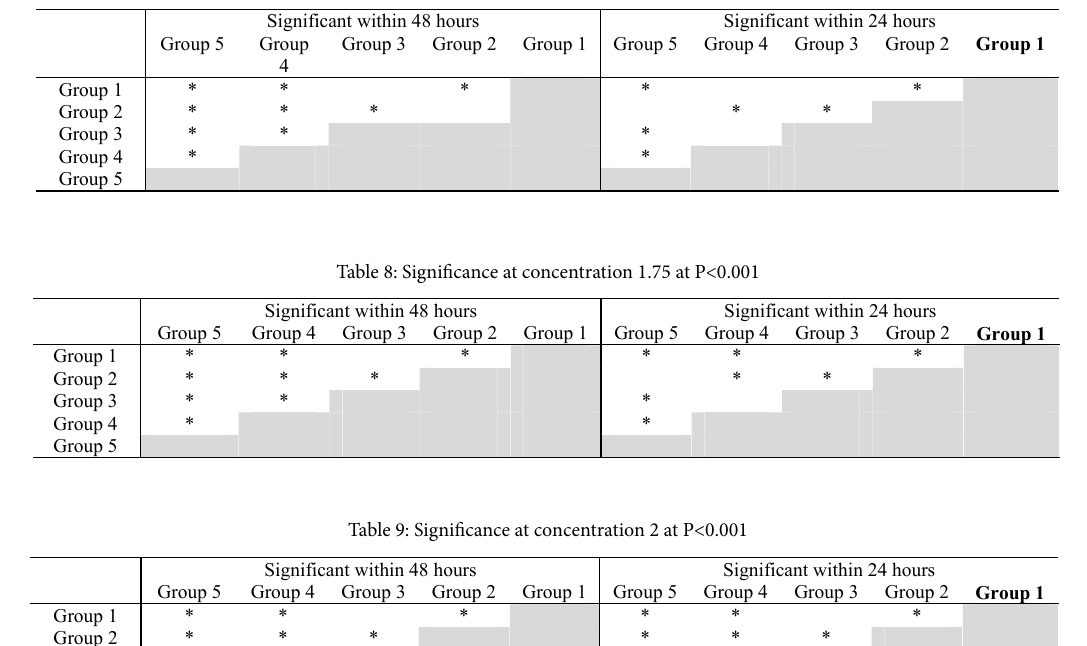
Table 7. Significance at concentration 1.5 at P<0.001 Table 7: Significance at concentration 1.5 at P<0.001